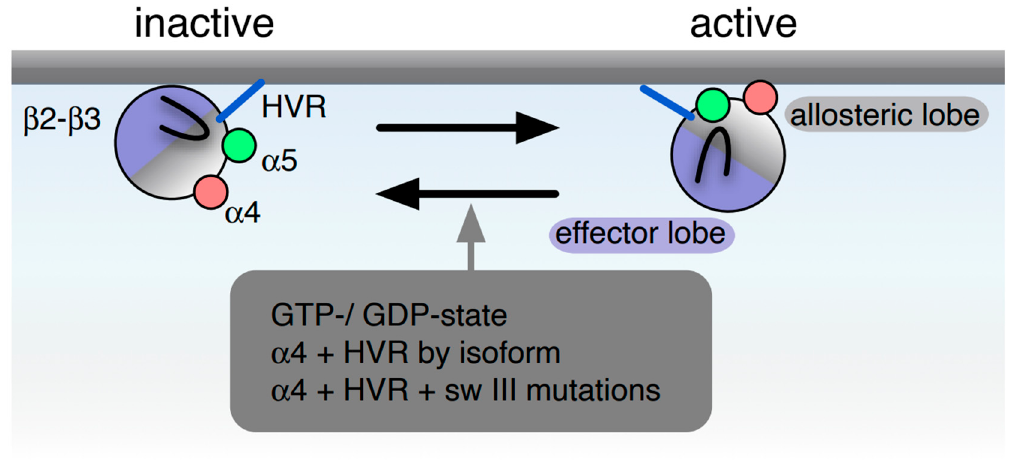
Figure 1. Isoform- and activation-state dependent Ras reorientation on the plasma membrane. Computational and experimental data have provided support for distinct orientation states of Ras on the membrane. Earlier work showed that in the inactive (GDP-bound) state H-Ras contacts the membrane mostly via the lipid modified HVR (blue). However, in the active (GTP-bound) state the dominant conformations have helix α 4 (pink) contacting the membrane. Follow up work further suggested that properties of helix α 4 and the HVR can shift the reorientation balance. As described previously, switch III (sw III) comprises the β 2- β 3 loop (black loop) together with helix α 5 (green) [21].